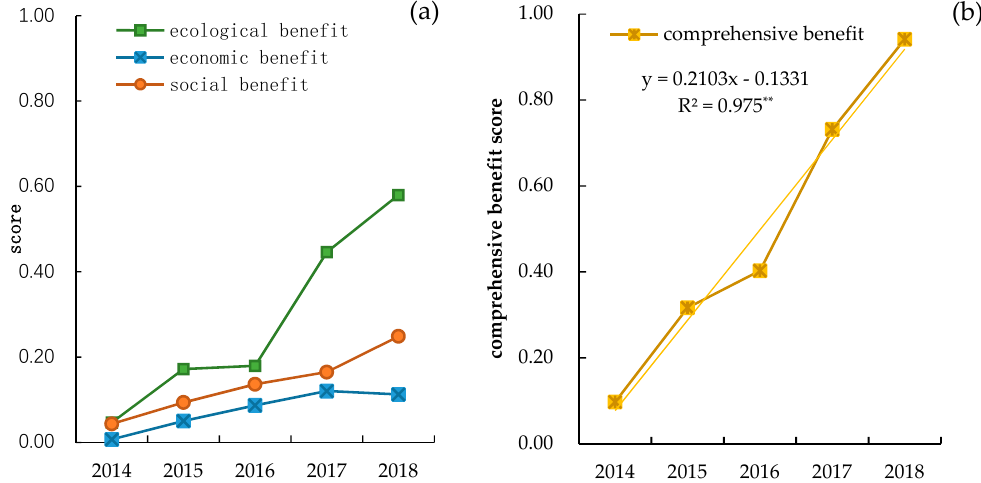
Figure 4. Benefit score of soil and water conservation in Shendong Coal Mining Subsidence Area from 2014 to 2018. ( a ) Three benefit growth curves; ( b ) Comprehensive benefit growth curve. ** represents statistical significance at a 0.05 level.